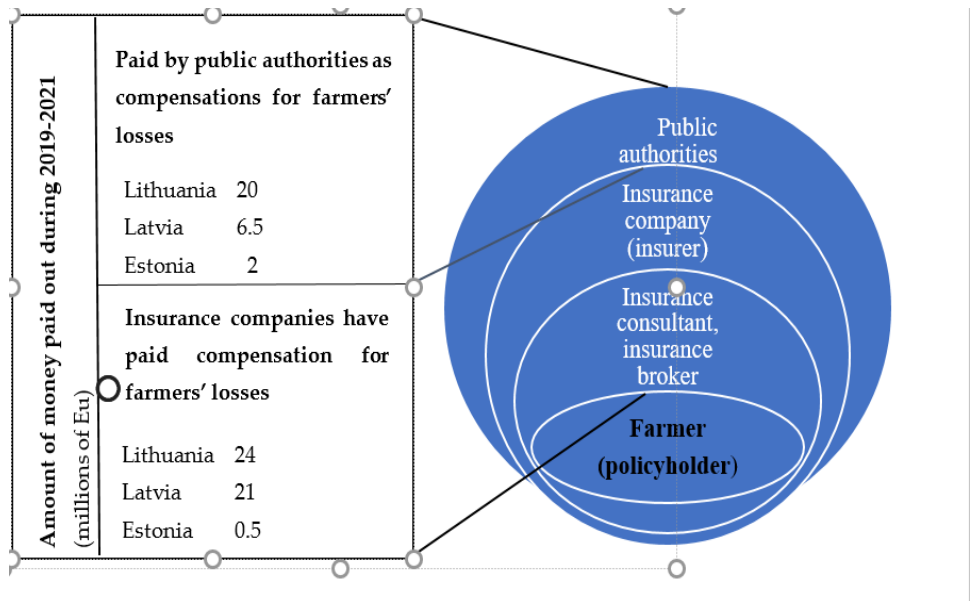
Figure 1. Structure of insurance system participants in the Republic of Lithuania.